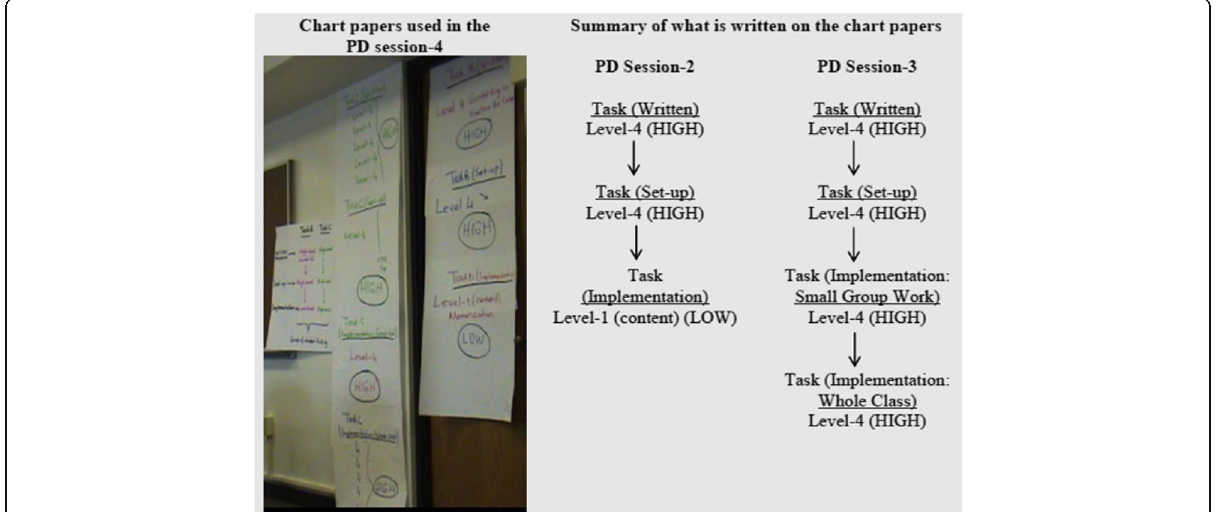
Fig. 1 Chart papers from the fourth TSCD-PD